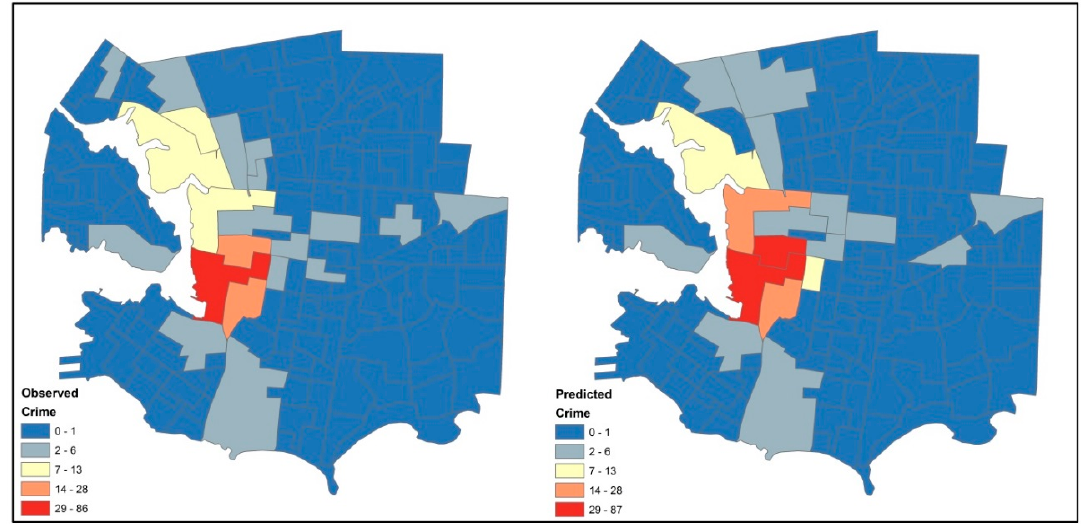
Figure 3. Observed and predicted counts of assault and disorder crime reports on Friday and Saturday nights, between 7:00 p.m. and 4:00 a.m. from 16 January 2015 to 29 May